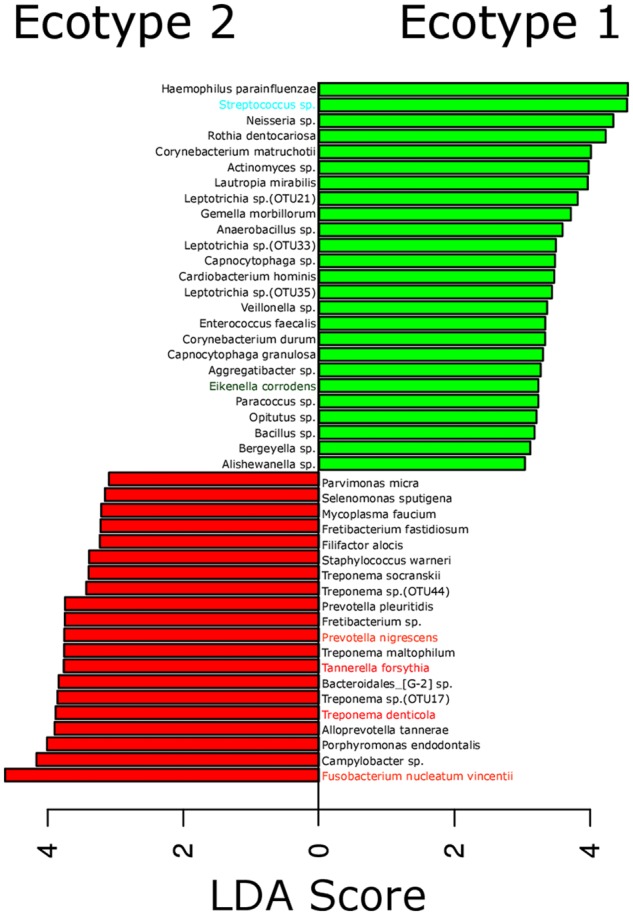
Most differentially abundant OTUs between the microbial ecotypes 1 and 2. Bar plot representing the most differentially abundant OTUs between the ecotypes 1 and 2 as detected by a LDA effect size (LEfSe) analysis (LDA score > 2). OTUs signature specific to the ecotypes 1 and 2 are, respectively, in green and red. OTUs are named by their taxonomic assignment and color coded depending of their membership to the red (in red), orange (in orange), green (in green), and yellow (in blue) complex.